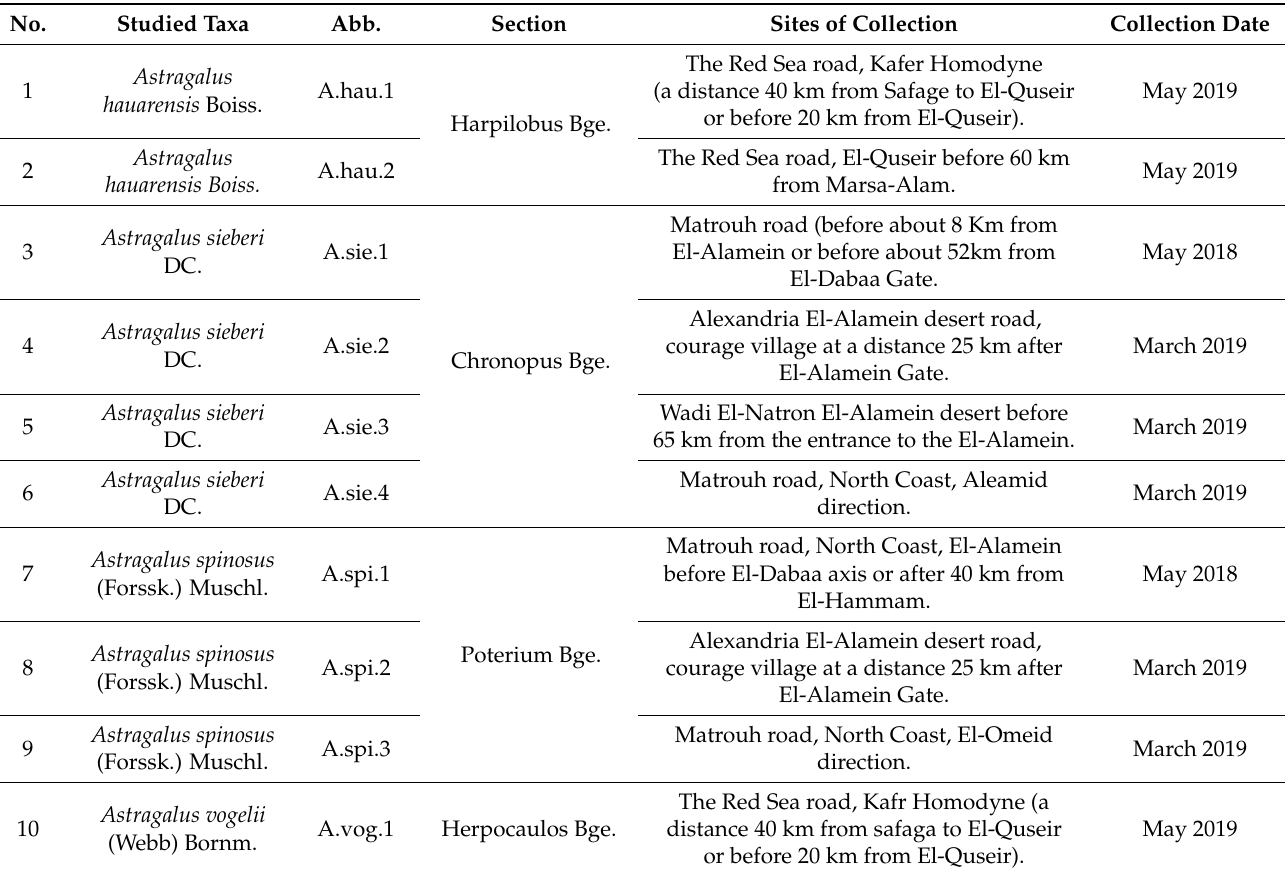
Table 1. The studied taxa, collection details, and their sectional delimitation according to Podlech [39]. ( Astragalus species arranged